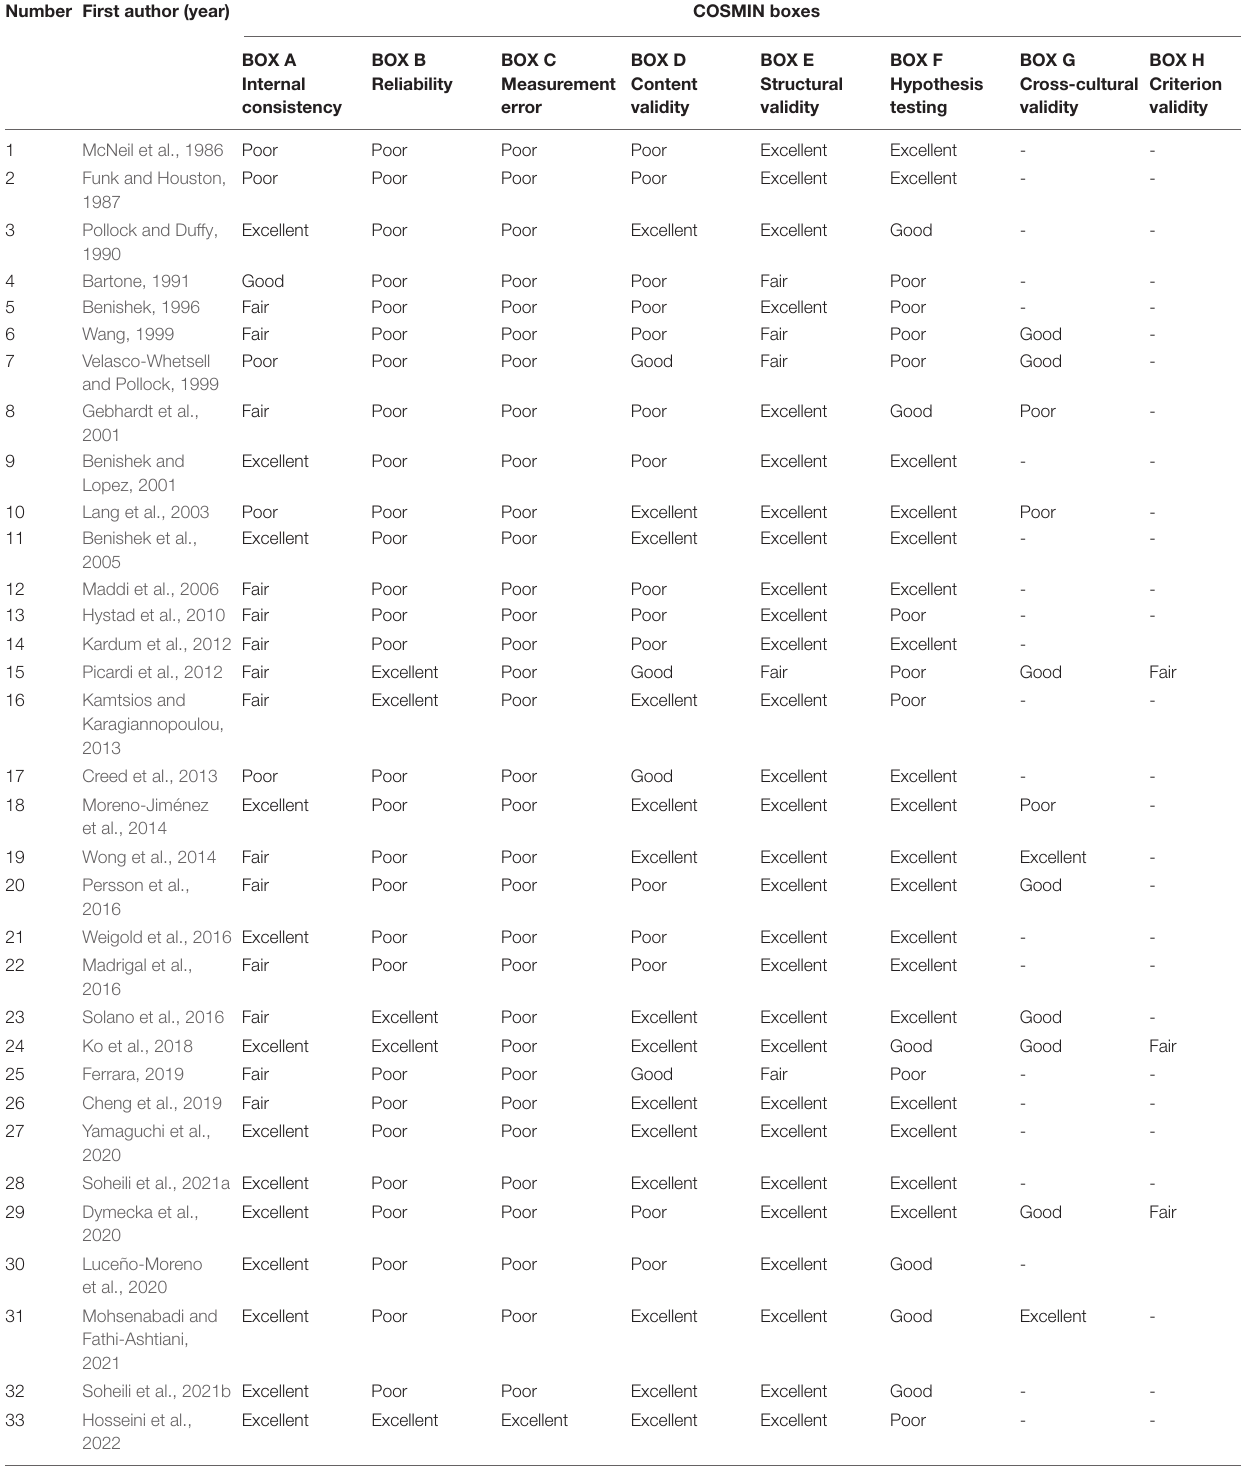
TABLE 4 | COSMIN quality